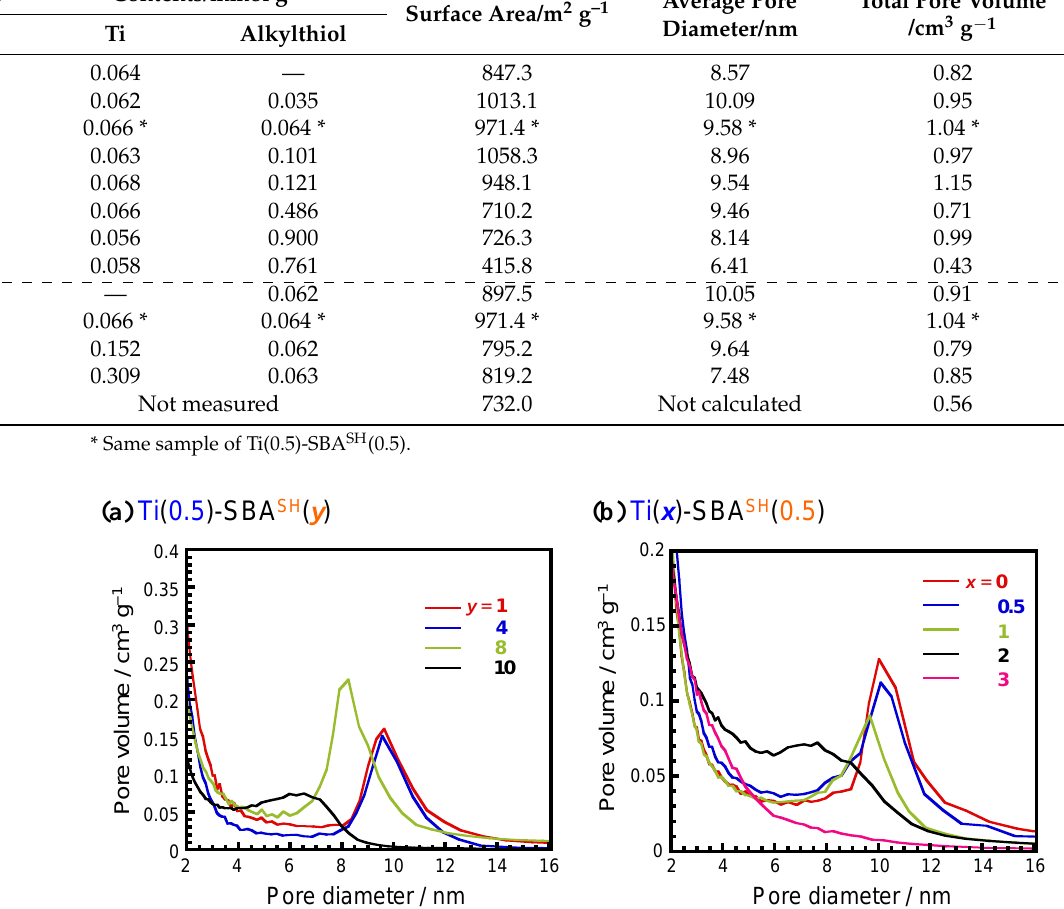
Figure 1. The distribution of the pore diameters of the bi-functionalized supports. ( a ) Ti(0.5)-SBA SH ( y ); ( b ) Ti( x )-SBA SH (0.5).